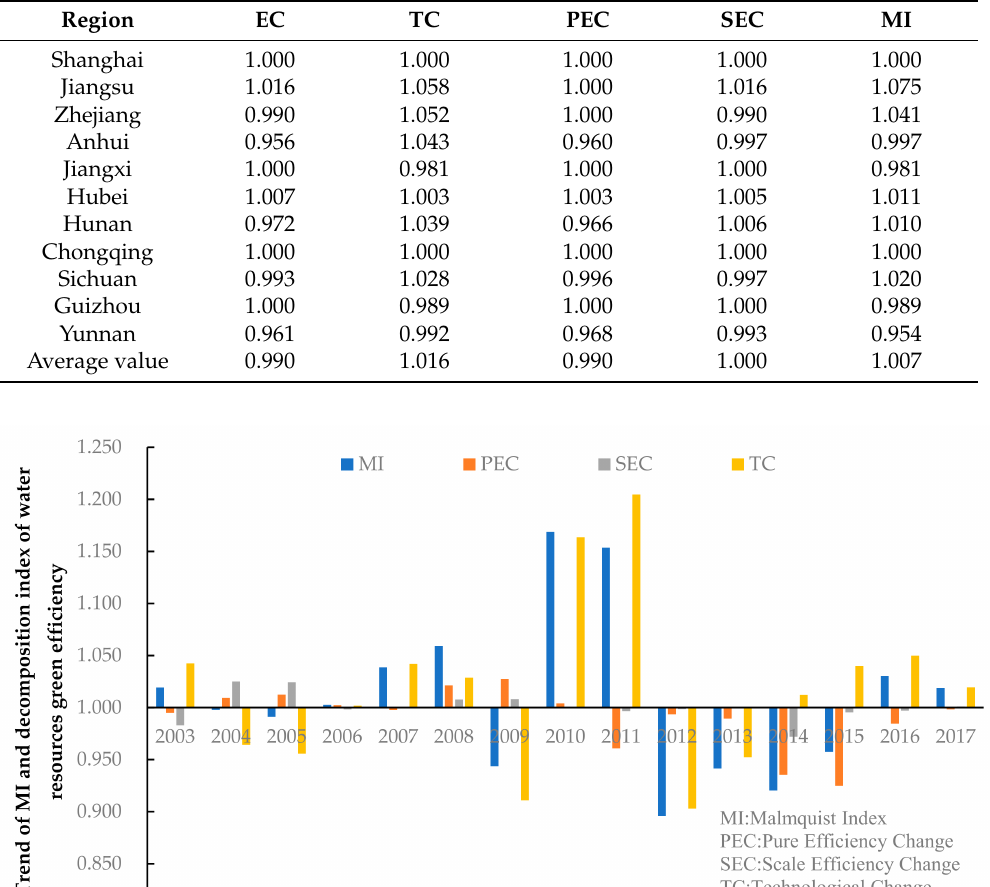
Table 3. Mean values of Malmquist Index (MI) and its decomposition index of green efficiency of water resources in the Yangtze River Economic Belt.